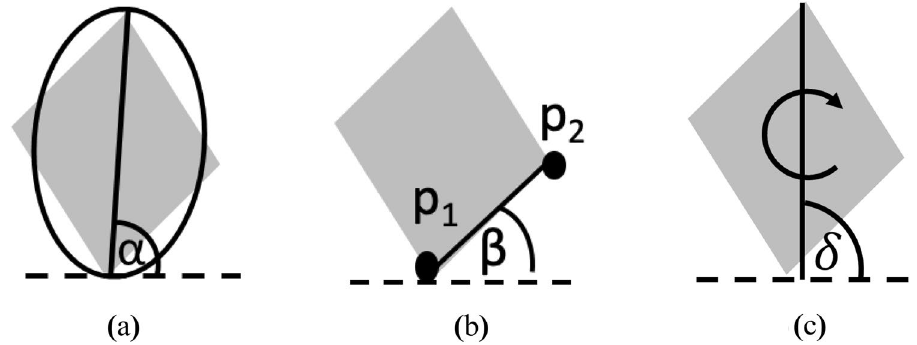
Figure 1. Image alignment methods . ( a ) Equivalent ellipsis method, ( b ) extrema method and ( c ) manual alignment method.